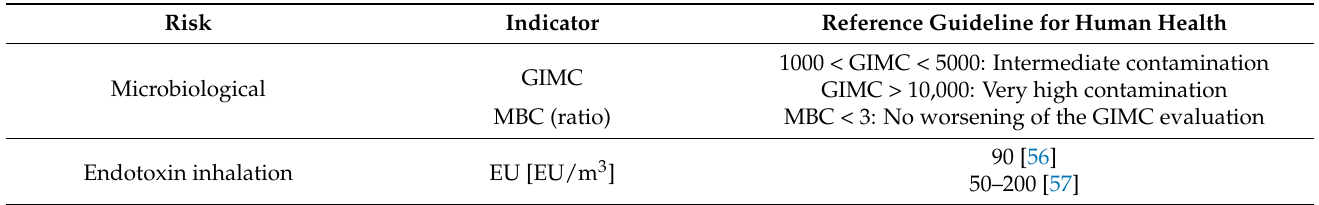
Table 9. GIMC and MBC indexes. Adapted from